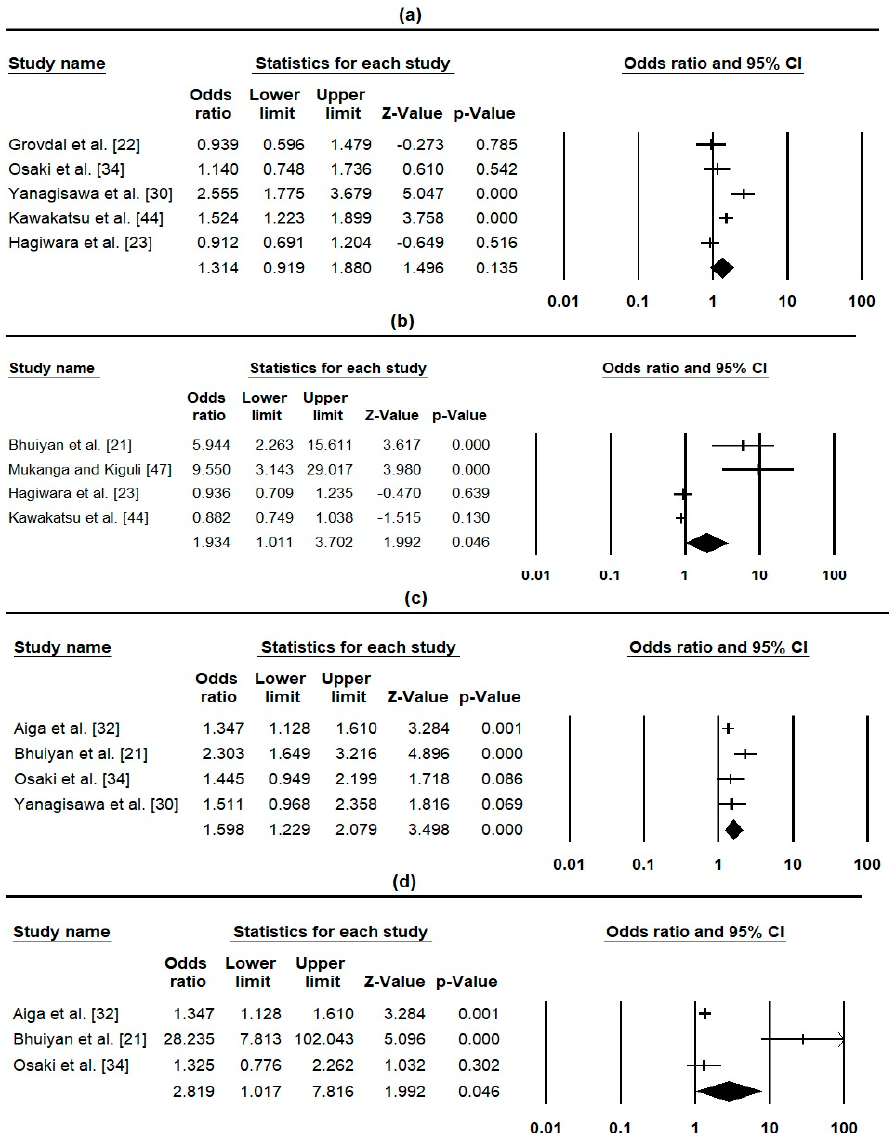
Figure 2. Forest plot of PHCHR effect on health-related outcomes: ( a ) Utilisation of child health care (Heterogeneity: Q-value = 23.65, p = 0.00, I 2 = 83.09), ( b ) Uptake of child immunisation (Heterogeneity: Q-value = 31.19, p = 0.00, I 2 = 90.38), ( c ) Utilisation of ante-natal care (Heterogeneity: Q-value = 7.75, p = 0.05, I 2 = 61.31), ( d ) Practice of breast-feeding Heterogeneity (Heterogeneity: Q-value = 21.20, p = 0.00, I 2 = 90.57).